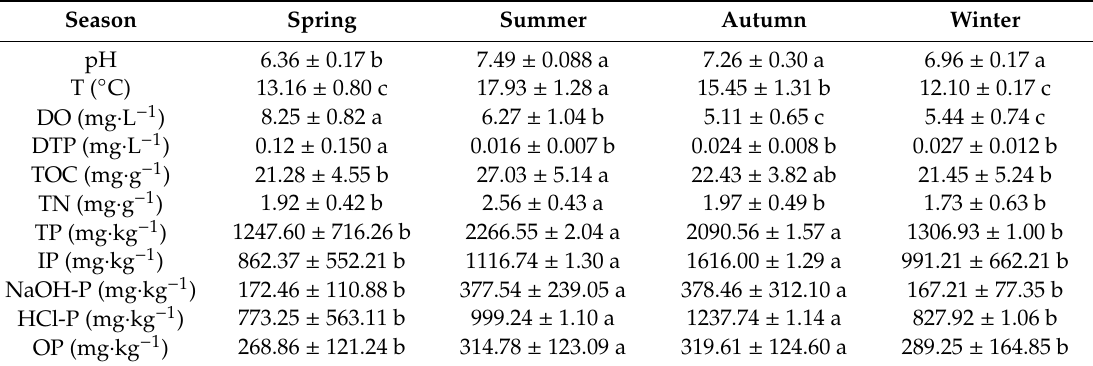
Table 1. Physicochemical factors of sediments and overlying water in di ff erent seasons. Season Spring Summer Autumn Winter pH 6.36 ± 0.17 b 7.49 ± 0.088